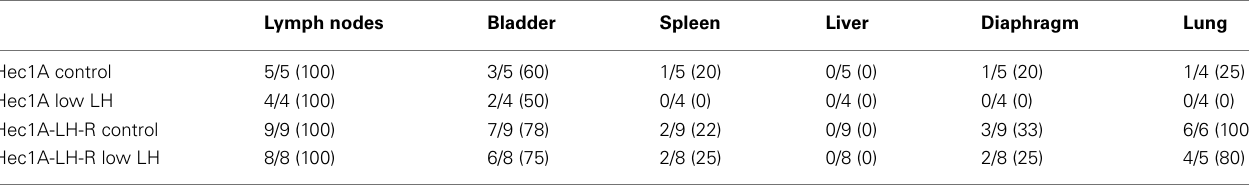
Table 1 | Evaluation of distant metastasis in the orthotopic experimental model of endometrial cancer